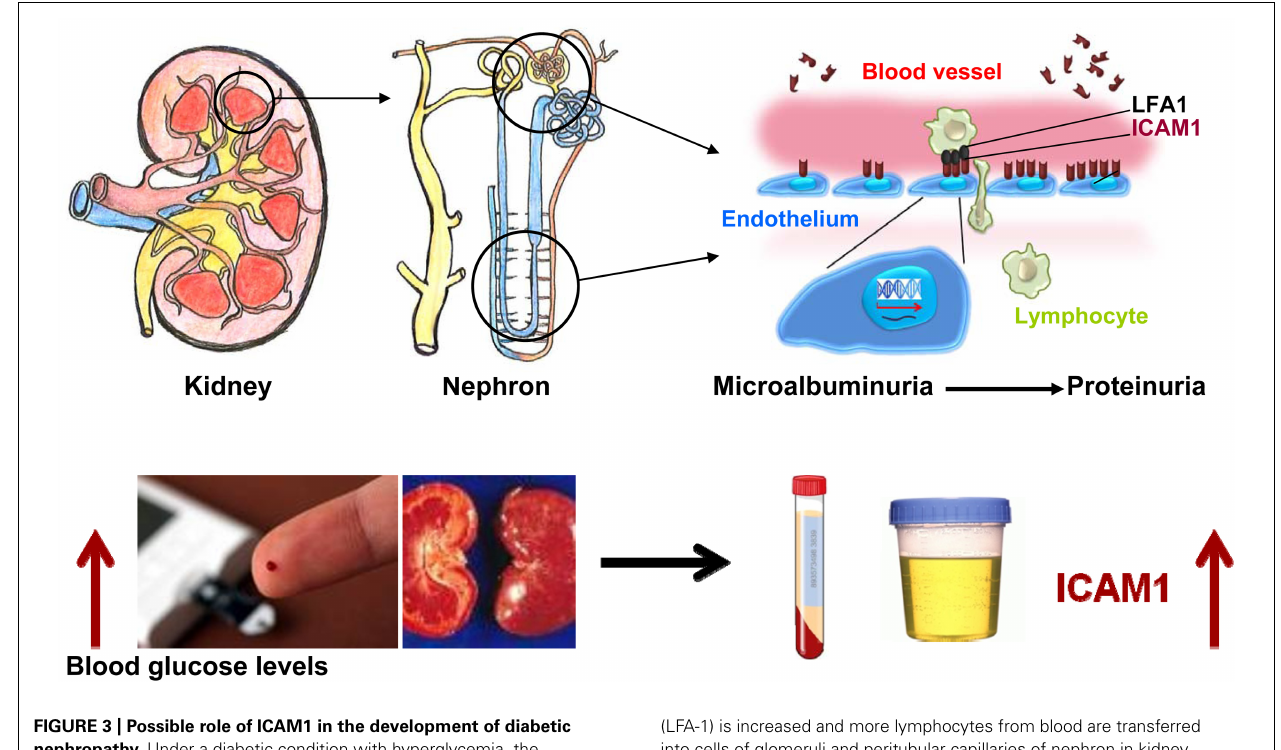
FIGURE 3 | Possible role of ICAM1 in the development of diabetic nephropathy. Under a diabetic condition with hyperglycemia, the ICAM1 gene transcription in the nuclei is increased and the ICAM1 gene expression on the surface of endothelium cells is up-regulated. ICAM1 protein binding activity with leukocyte adhesion protein-1